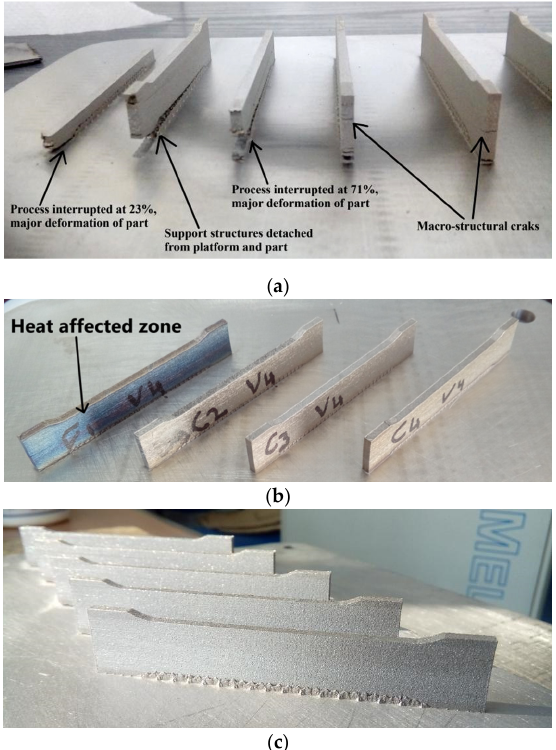
Figure 9. Effect of different parameters on processability: ( a ) Unstable processability and defects generated; ( b ) Part with heat-affected zone, relatively stable processability (energy density of 142 J / mm 3 , sample R3); ( c ) Stable processability using proper SLM parameters, free of cracks or warping (sample S3).